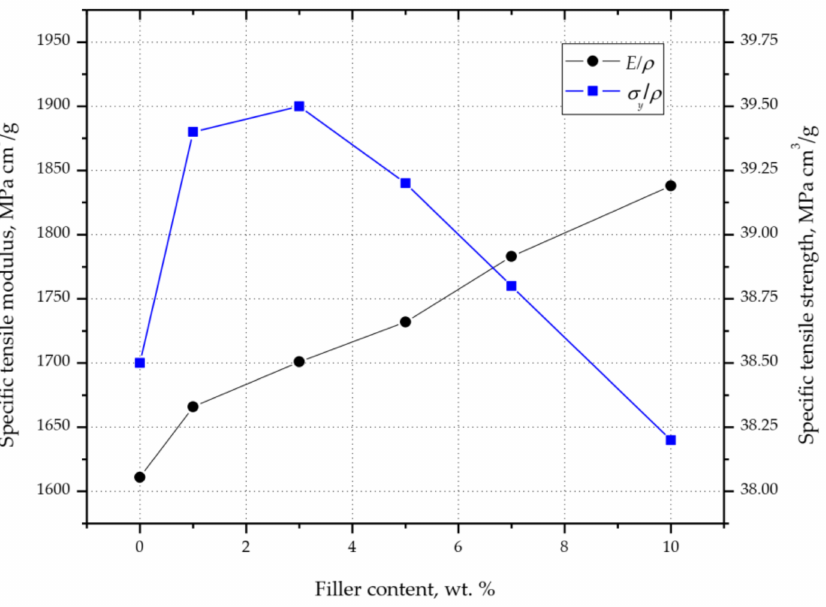
Figure 8. Changes in PP/silica composites’ mechanical properties as a function of filler